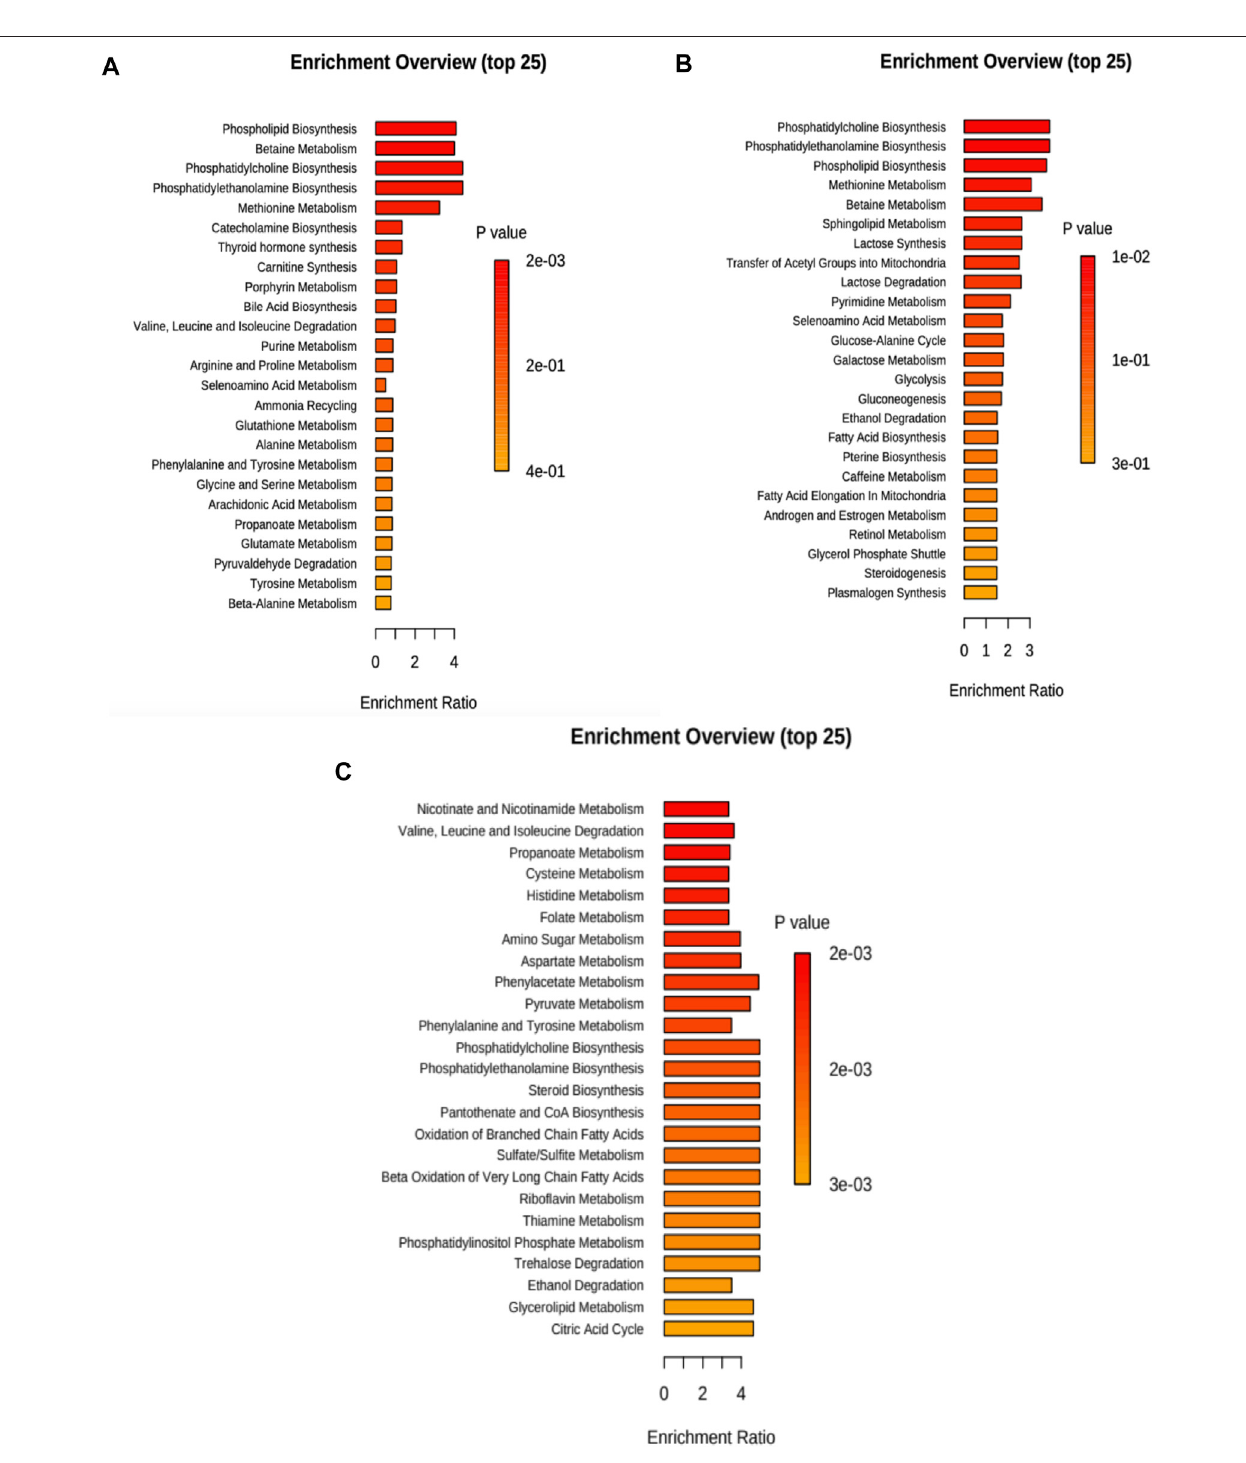
FIGURE3| Metabolite set enrichmentoverview for each case considering20and 40 min treatment. (A) Notreatment, (B) cisplatin, and (C) CasIIgly. Thelengthof the bar represents the enrichment of the pathway and the color represents the statistical signi fi cance (red: mostly signi fi cant, orange: less signi fi cant).